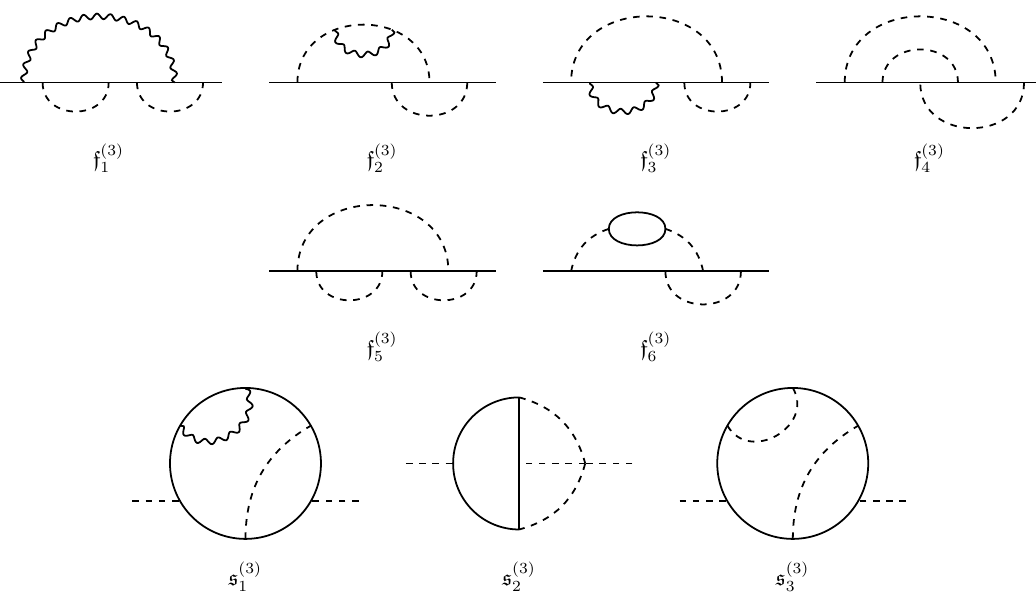
Figure 8 . Graph representation of the TSs appearing in S (3)